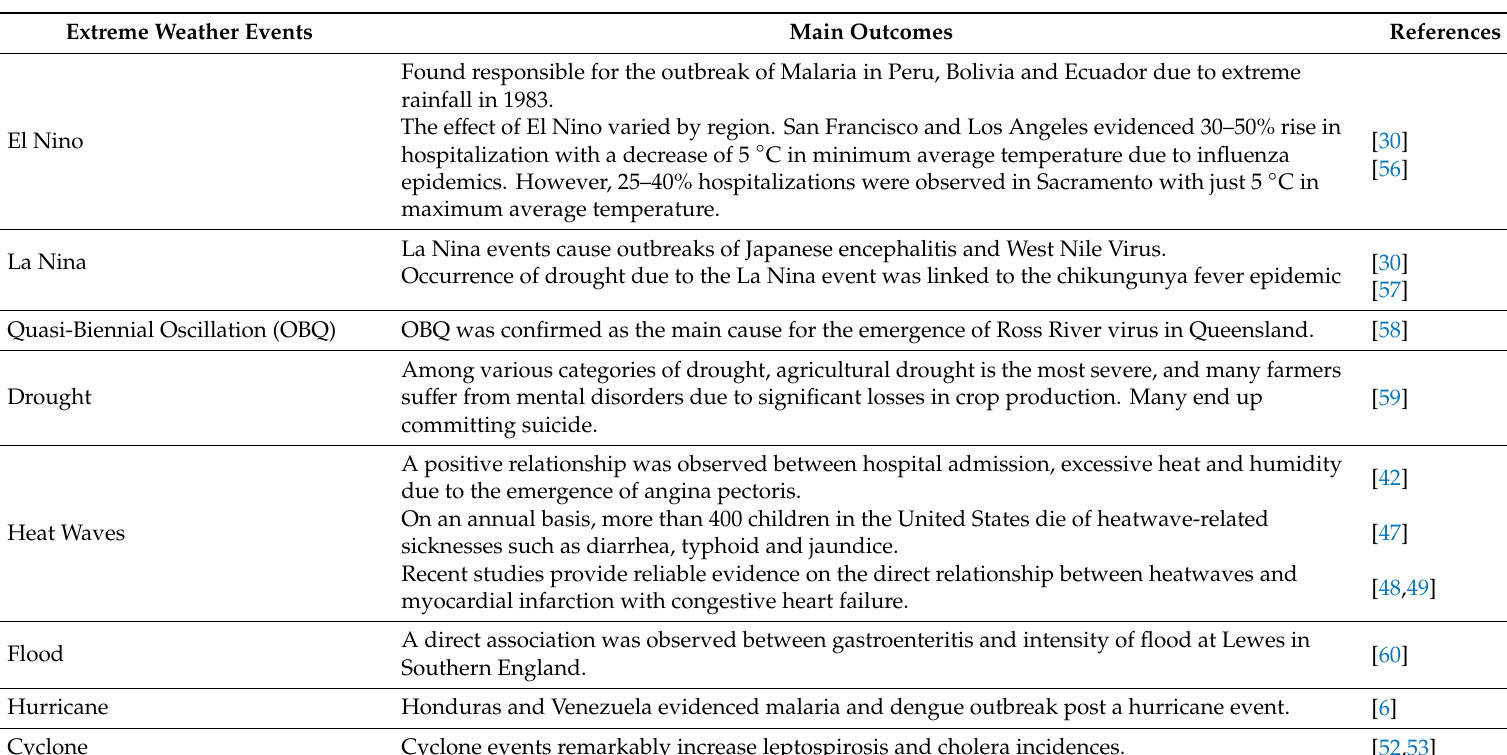
Table 1. Key studies highlighting the impacts of extreme weather events on human